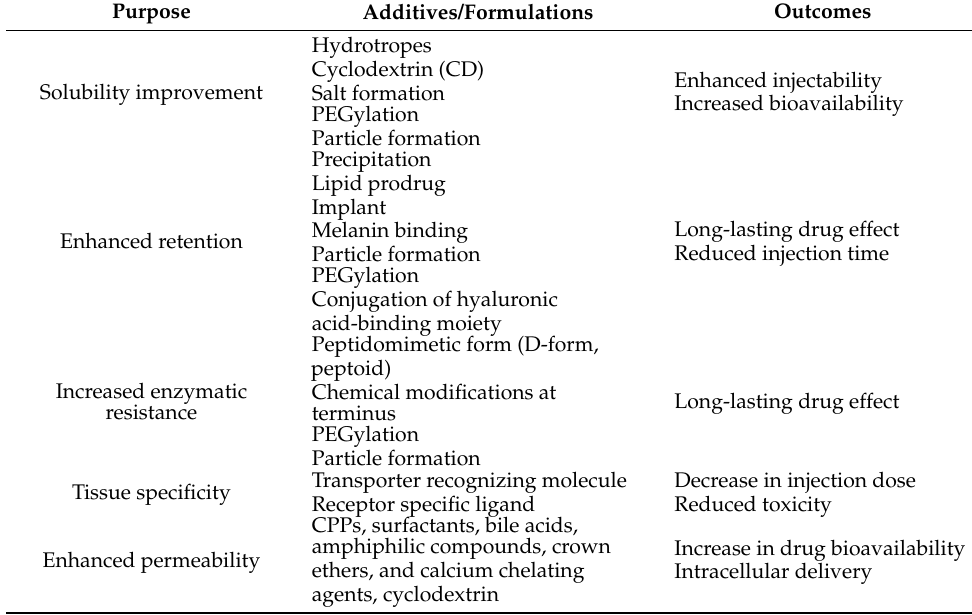
Table 2. Additives and formulation methods to achieve essential pharmacokinetic properties for the efficient retinal delivery of peptidomimetic